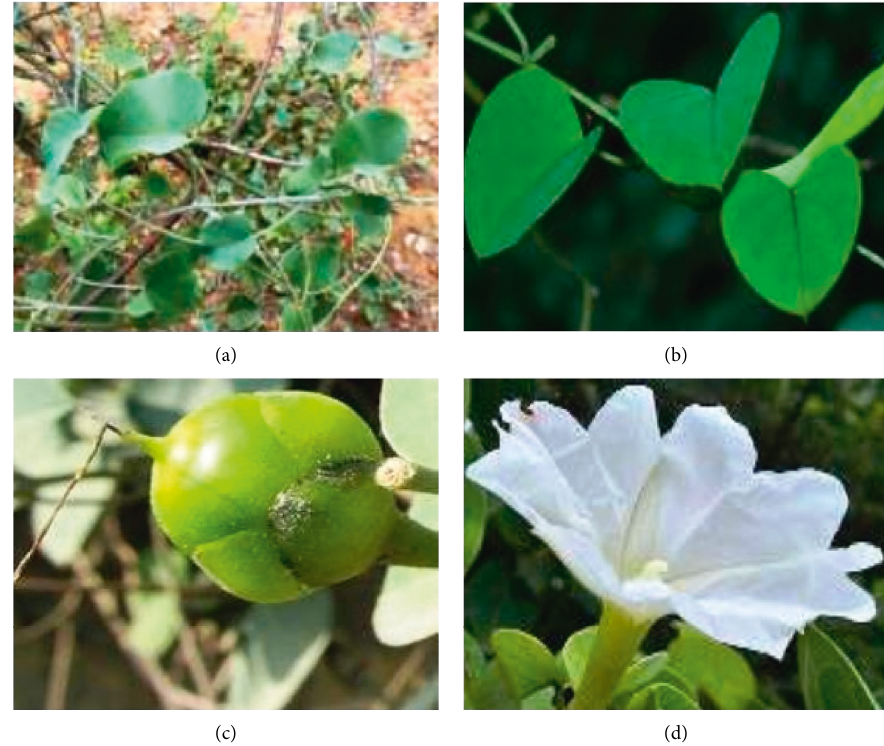
Figure 3: R. hypocrateriformis. (a) whole plant; (b) leaf; (c) fruit; (d) flower.